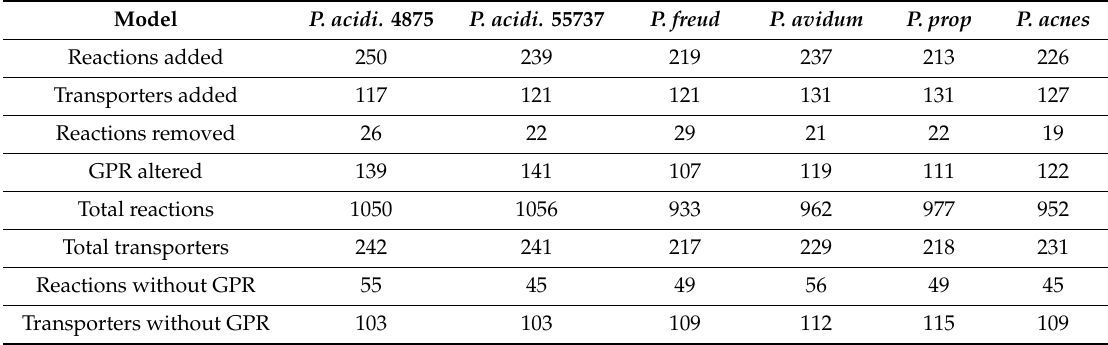
Table 3. Summary of extent of manual curation across the di ff erent models. GPR: gene–protein– reaction associations.